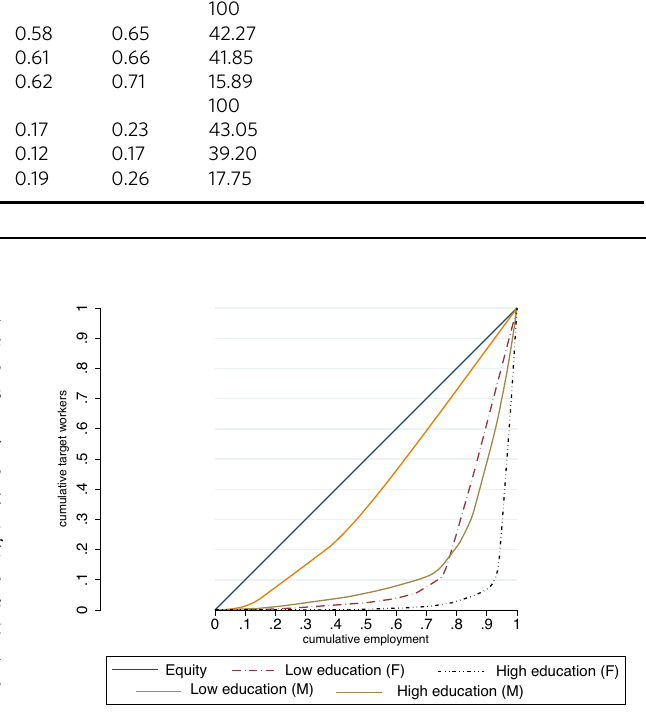
Fig. 4 Occupational segregation by gender and education. The fi gure shows the occupational segregation of male and female workers with respect to different education